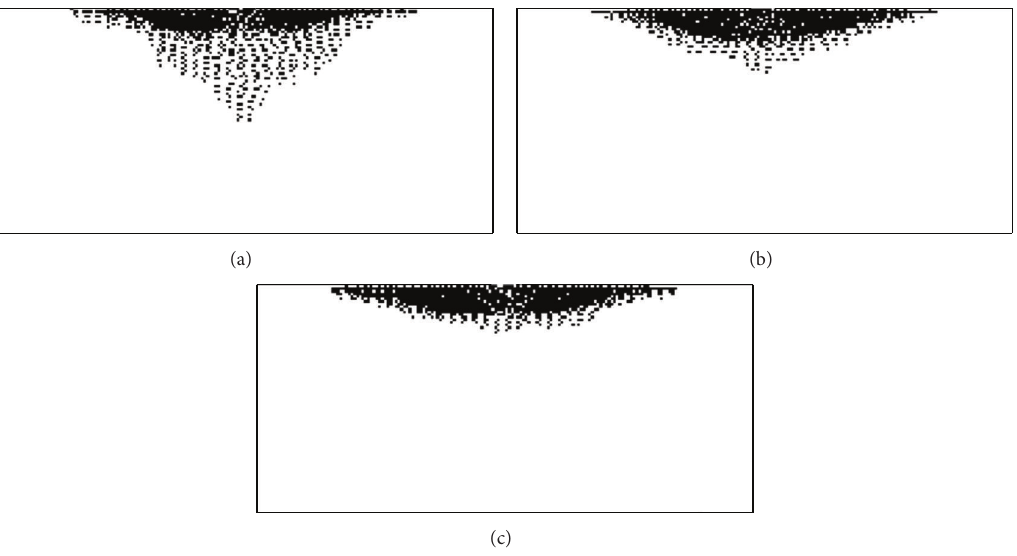
Figure 3: Simulations of evacuation in a stadium.